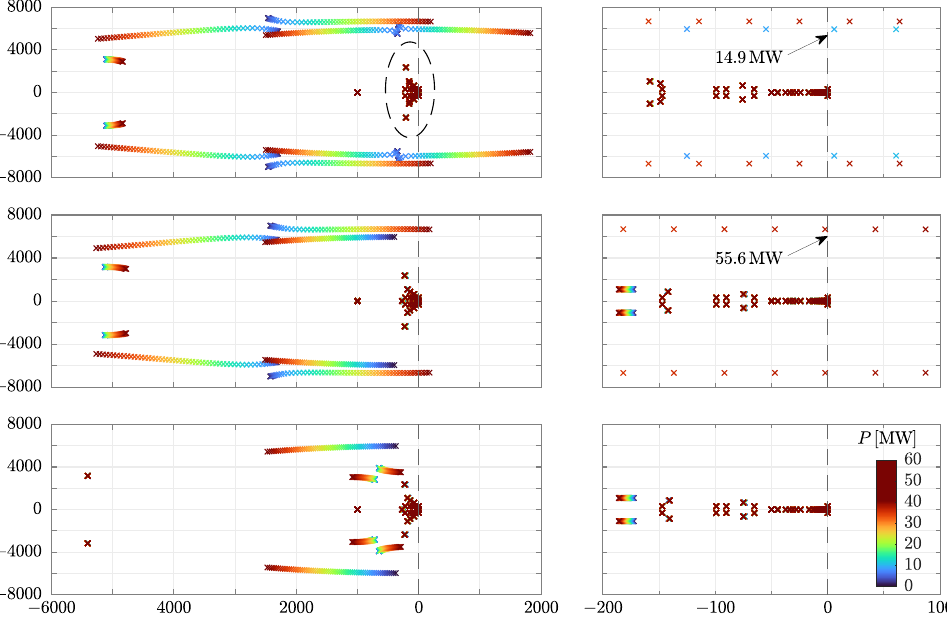
Figure 7. Evolution of the main eigenvalues of the IEEE 14 power system shown in Figure 6 when the active power reference P of the P / Q type MMC 1 converter at BUS 5 is swept in the [ 0,60.7MW ] interval. For each row, the panels on the right are an inset of those on the left. The vertical dotted line in each panel denotes the null real part of the eigenvalues. Eigenvalues are colour-coded based on P (see the colour bar in the bottom panel, right side) to better identify the power reference values that make the system unstable, which are highlighted by arrows in the panels on the right. Top row: base case. The real part of the eigenvalues inside the dashed ellipse is close to zero, but it is always negative regardless of P (the same holds for the other panels). Middle row: case in which MMC 1 includes the droop control and low-pass filter described in Equation (11). Bottom row: compared to the previous case, a shunt capacitor is also added to the AC -side of MMC 2. In all cases, dynamic models of lines and transformers are used, together with constant impedance load models behind OLTC